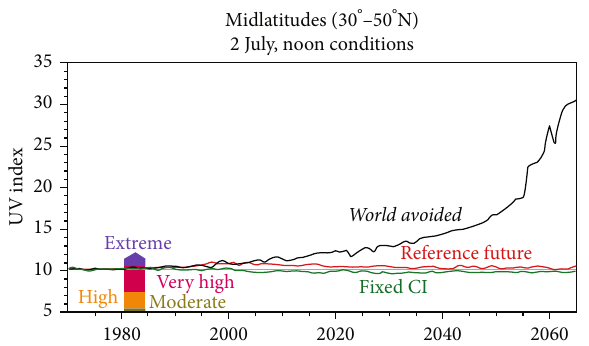
Figure 3: New cases of nonmelanoma from 2017 to 2020 worldwide (Source: [1]).